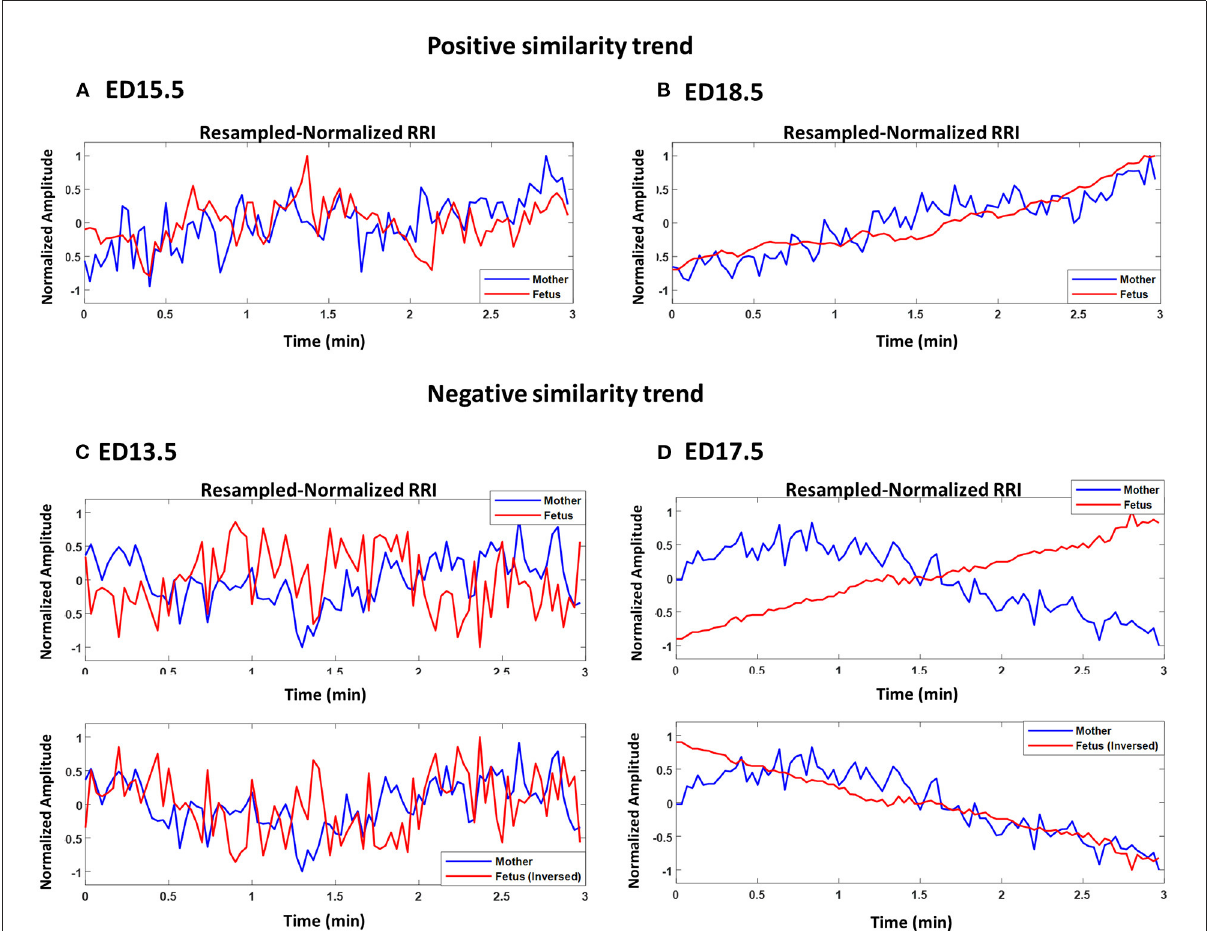
FIGURE2 Demonstration of maternal and fetal RR interval (RRI) similarities. All panels show resampled normalized maternal (blue) and fetal (red) RRI. (A) ED15.5, CC1: 0.42, CC2: 0.27, coherence low frequency (CLF): 0.084, coherence high frequency (CHF): 0.074. (B) ED18.5, CC1: 0.82, CC2: 0.67, CLF: 0.98, CHF: 0.92. (C) ED13.5, CC1: 0.29, CC2: − 0.18, CLF: 0.086, CHF: 0.074. (D) ED17.5, CC1: 0.85, CC2: − 0.85, CLF: 0.097, CHF: